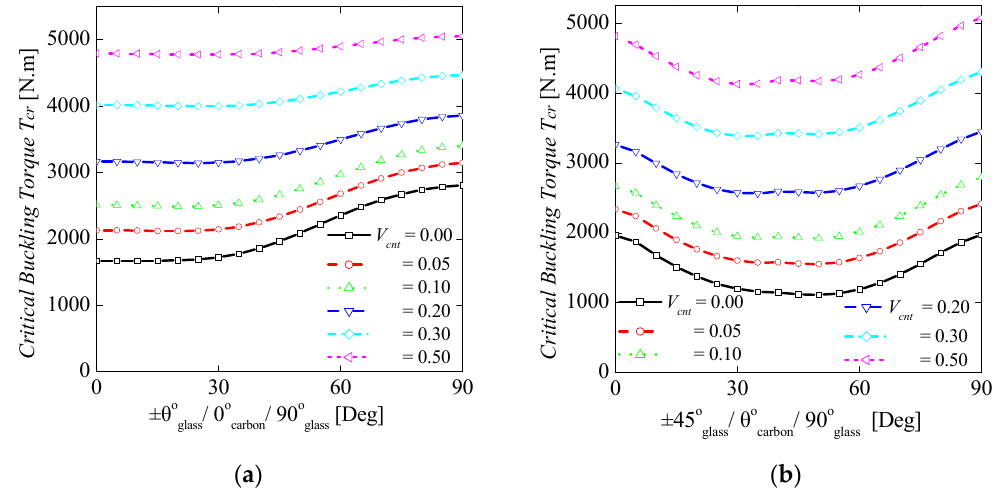
Figure 8. Critical buckling torque as a function of fiber orientation angle ( θ °) for various 433 CNT volume fractions. A hybrid composite drive shaft having four layers stacking of ( a ) [± θ ° glass /0° carbon /90° glass ] and ( b ) [±45° glass / θ ° carbon /90° glass ] was analyzed with length = 1730 mm, radius = 50.8 mm, and wall thickness = 2.032 mm. To obtain the critical buckling torque eigenvalue, buckling analysis was conducted.